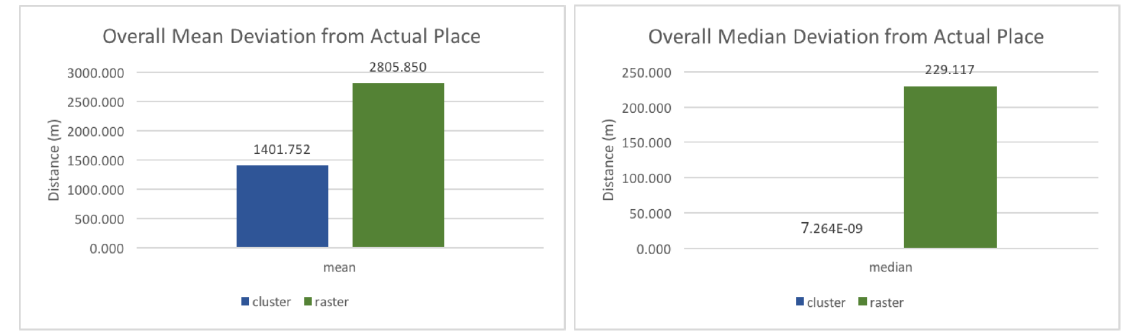
Figure 7. Overall distance deviation of the exact coordinate prediction from the actual longitude/latitude. It can be seen that in the cluster-based approach most coordinates are predicted reasonably well, with some large outliers that lead to a high average